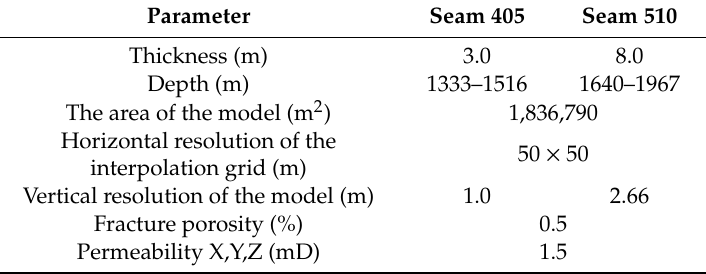
Table 3. Structural parameters of the model for seams 405 and 510.